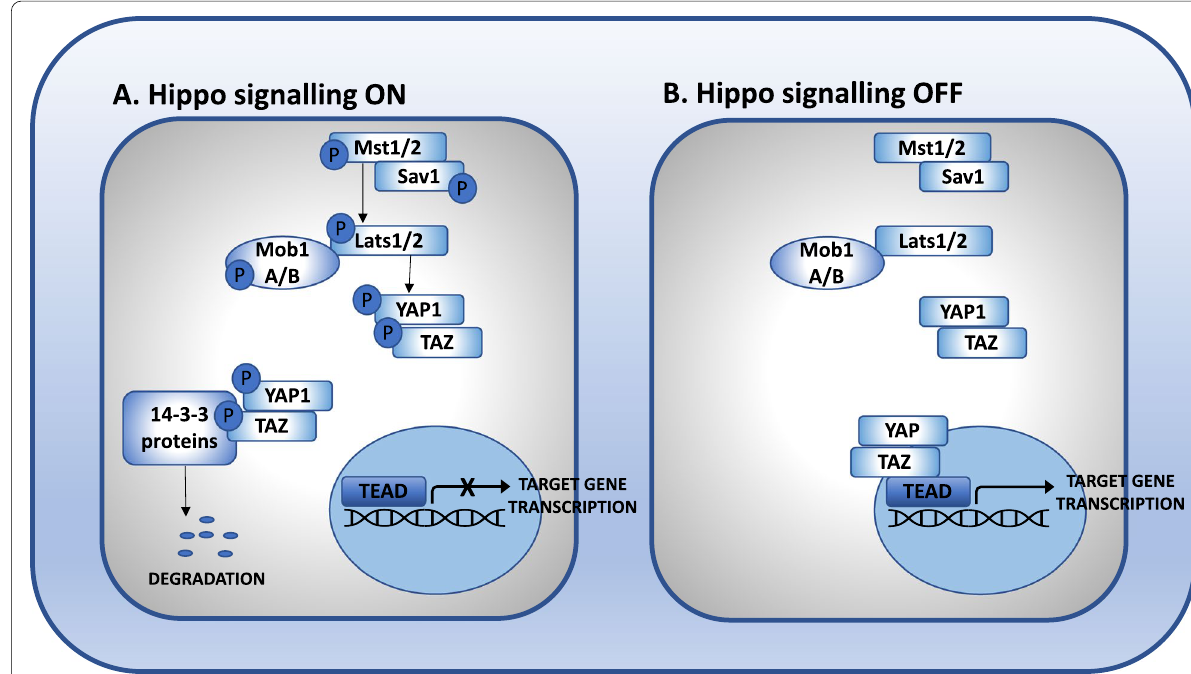
Fig. 3 Schematic overview of the Hippo signaling pathway. A “Hippo signaling ON”: activation of the Hippo pathway leads to inactivating phosphorylation and cytoplasmic retention of the co-transcriptional activators YAP1 and TAZ. Specifically, activation of mammalian sterile 20-like protein kinases 1 and 2 (MST1 and MST2) activates large tumor suppressor kinases 1 and 2 (LATS1 and 2) in partnership with their scaffold molecule Salvador Family WW Domain Containing Protein 1 (SAV1). LATS1 and 2 and their partners, MOB kinase activators 1A and B (MOB1A and MOB1B), in turn phosphorylate the co-transcriptional activators YAP1 or TAZ at several serine residues causing their inactivation. When phosphorylated at specific amino acid residues, YAP and TAZ bind the scaffold molecule 14-3-3 and are eventually transported to the proteasome for degradation. B “Hippo signaling OFF”: when the activity of the Hippo pathway is reduced, the unphosphorylated YAP and TAZ migrate to the nucleus and associate with various DNA-binding proteins, e.g., TEA domain proteins (TEAD), which control transcription of target